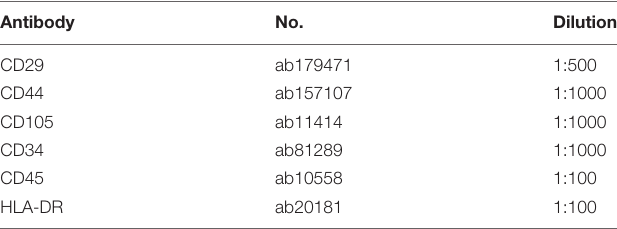
TABLE 1 | Antibodies used in flow cytometry. Antibody No. Dilution